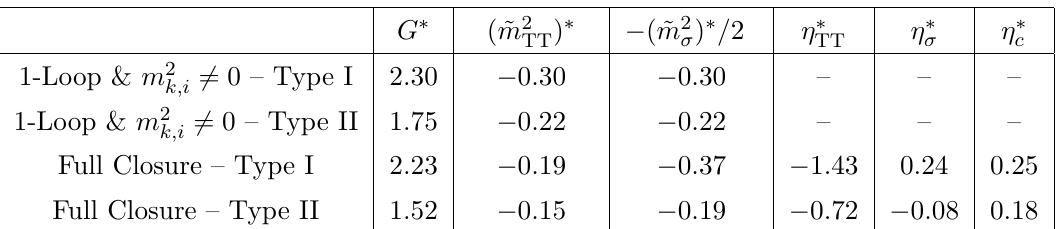
Table 3 . Fixed point structure in the truncated theory space de(cid:12)ned by G k , ~ m 2 We report on results obtained using both types of coarse-graining operators. The \1-Loop" closure corresponds to the case where we set (cid:17) TT = (cid:17) (cid:27) = (cid:17) c = 0. We use the nomenclature \Full Closure" for the (cid:12)xed point solutions involving anomalous dimensions reported in appendix